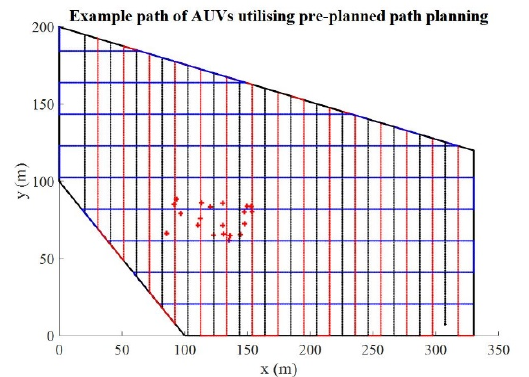
Figure 14. Paths of autonomous underwater vehicles (AUVs) utilising the pre-defined path planning (PPP) algorithm; maximal travel distance was set to 2700 m.